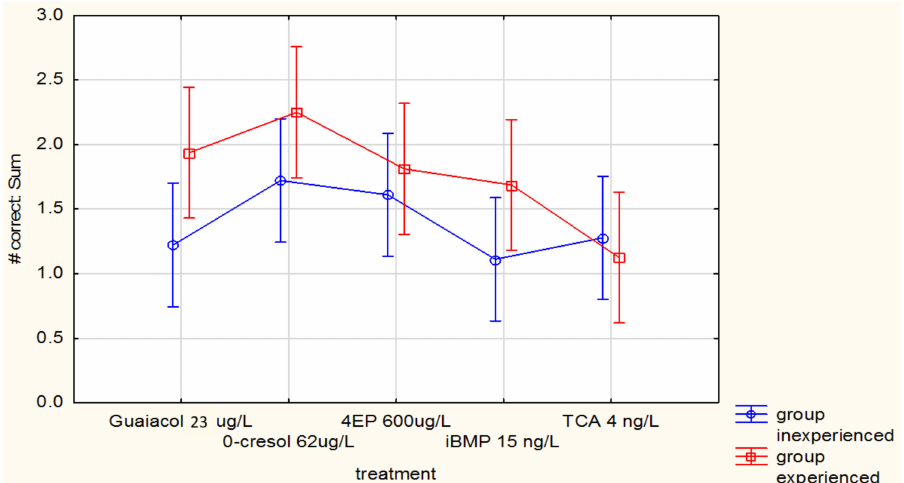
Figure 4. Number of correct judgements per experienced and inexperienced judge by 3-AFC Triangle Test (LS means) for individual compounds. Vertical bars denote 0.95 confidence